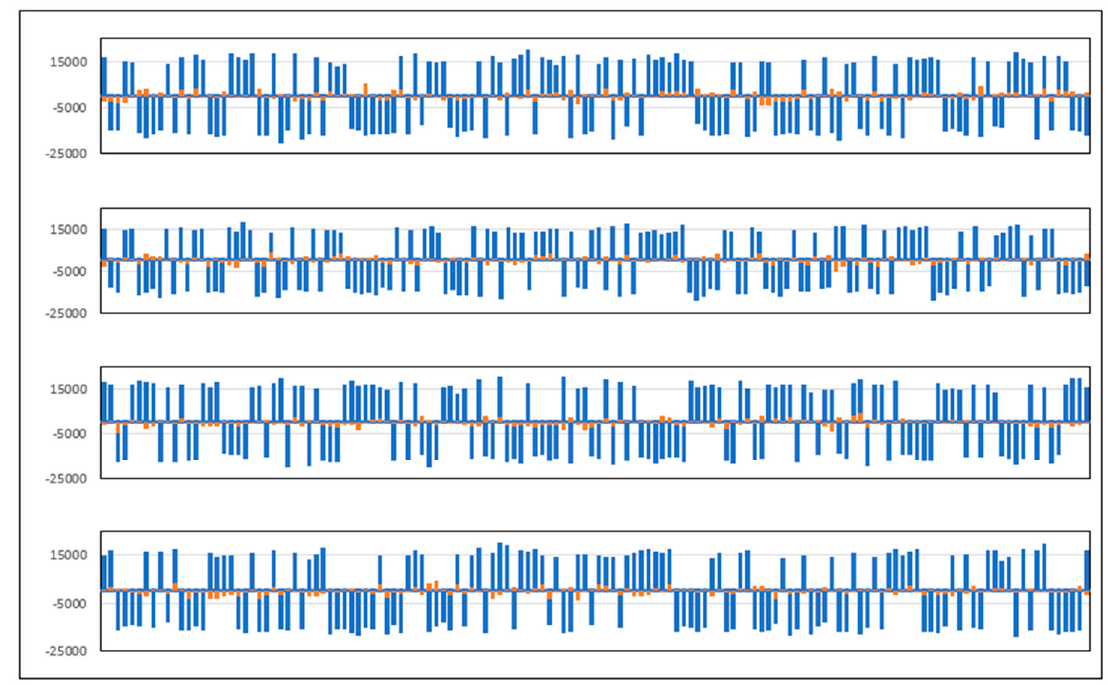
Figure 17. Prompt in-phase (blue) and quadrature (red) tracking results (for 500 ms) of GALILEO (European global satellite navigation system) E1B multi-channel processing of real data using GNSS-ISE (E02, E03, E05, E08). Tracking is performed with 4 ms integration time, 4 ms per GALILEO E1B bit.